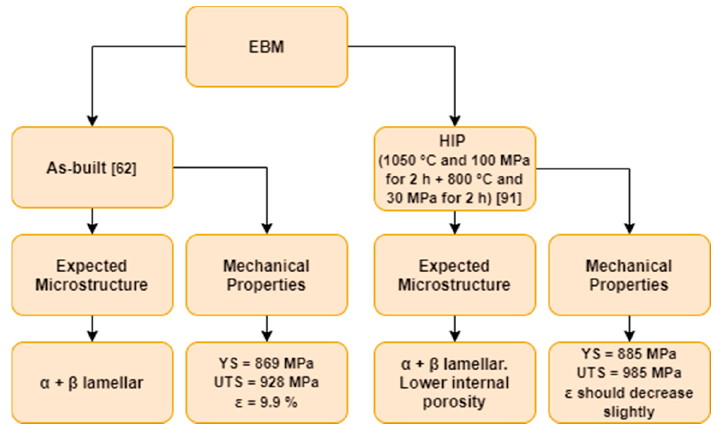
Figure16. Diagramoftheexpectedmicrostructureandmechanicalpropertiesofas-builtandheat-treated Figure 16. Diagram of the expected microstructure and mechanical properties of as-built and heat- EBMed Ti–6Al–4V treated EBMed Ti–6Al–4V samples.